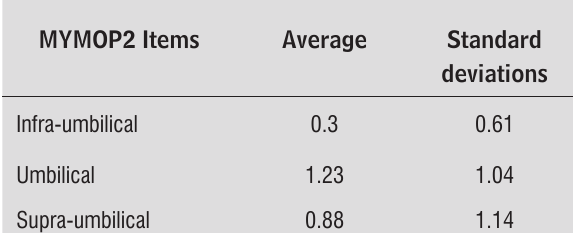
Table 4 - Average values and standard deviation for DRAM supra-umbilical, umbilical and infra- umbilical, Guarapuava/PR,